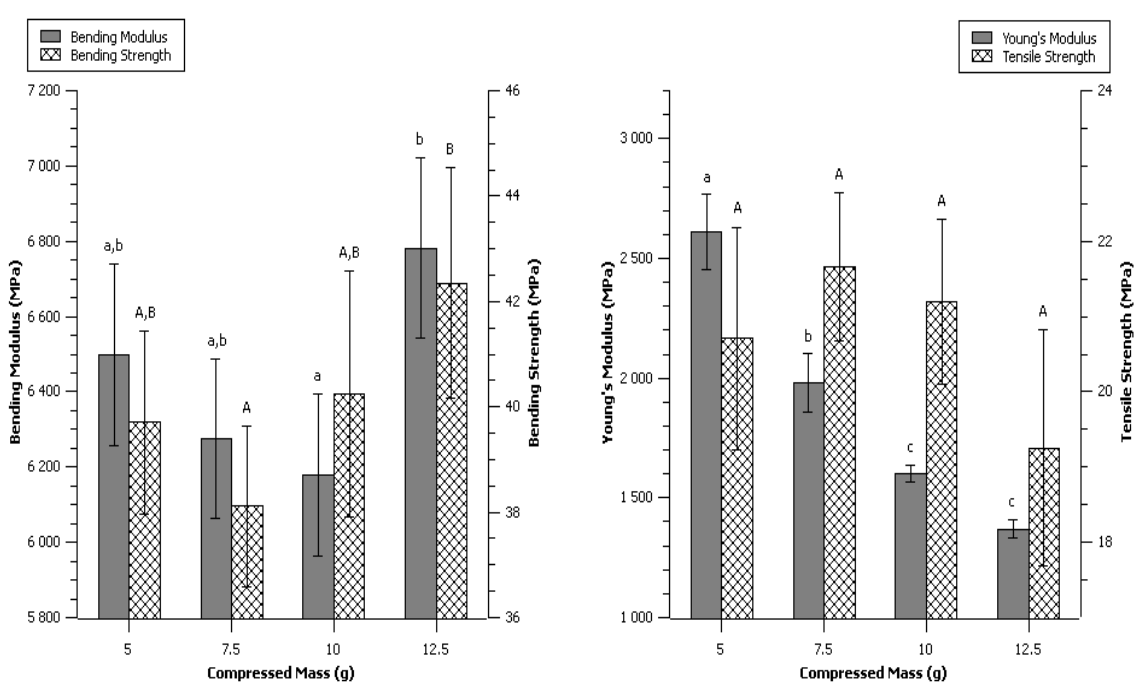
Figure 2. Effect of initial Compressed Mass. Data are given as mean ± confident interval (95%). The letters on top of the column express significant difference of means according to Scheffé test with a 95% confident level. Small letters for moduli and capital letters for